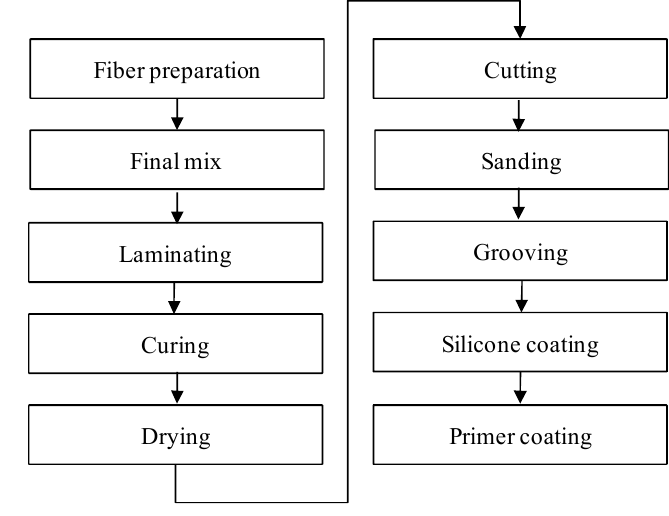
Fig.1. Production Processes of fibre cement product